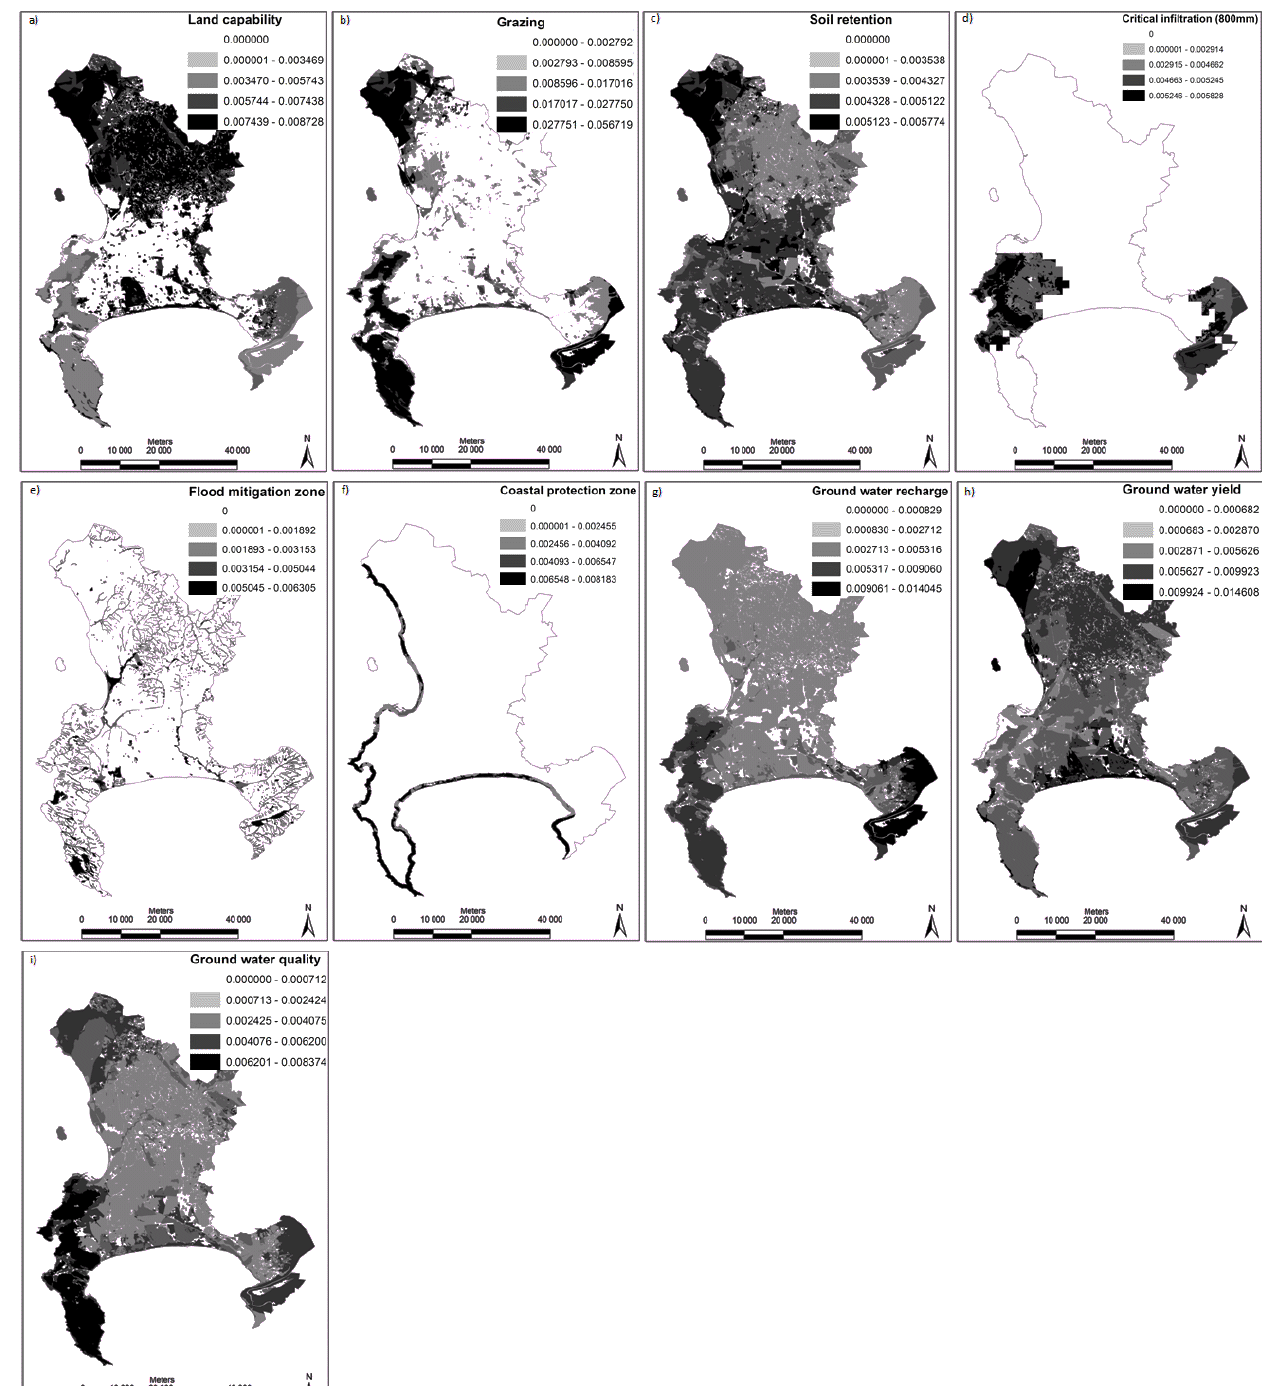
Fig. 3 . Maps of current ecosystem services based on individual service values associated with vegetation types and land transformation. Services values are weighted between 0 and 1 and plotted using Jenks natural breaks. Service include a) Land capability, b) Grazing provision, c) Soil retention, d) Critical infiltration, e) Flood mitigation, f) Coastal protection, g) Groundwater recharge, h) Groundwater yield, i) Groundwater